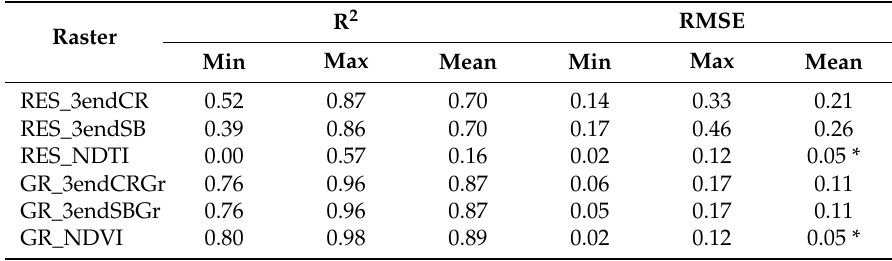
Table 6. Range (minimum (Min) and maximum (Max) values) and mean of linear regression parameters between unmixing fraction or index values compared to ground truth residue cover (RES) or green cover (GR) measures for nine 2015–2016 non-growing season images cited in Table 2. R 2 RMSE Raster Min Max Mean Min Max Mean RES_3endCR 0.52 0.87 0.70 0.14 0.33 0.21 RES_3endSB 0.39 0.86 0.70 0.17 0.46 0.26 RES_NDTI 0.00 0.57 0.16 0.02 0.12 0.05 * GR_3endCRGr 0.76 0.96 0.87 0.06 0.17 0.11 GR_3endSBGr 0.76 0.96 0.87 0.05 0.17 0.11 GR_NDVI 0.80 0.98 0.89 0.02 0.12 0.05